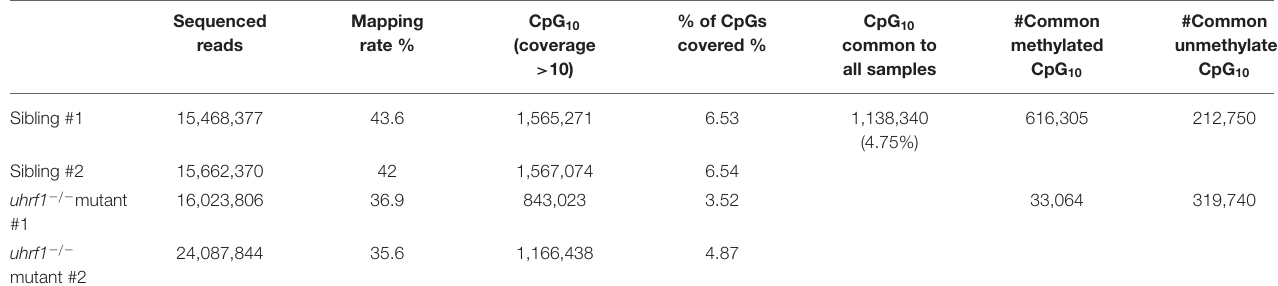
TABLE 2 | RRBS analysis of uhrf1 whole embryos at 5